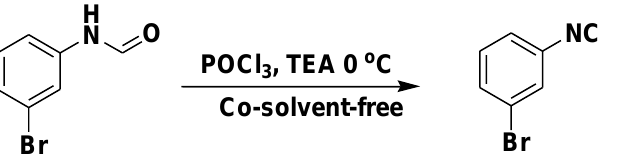
Figure 2. Dehydration of N -(3-bromophenyl)formamide to